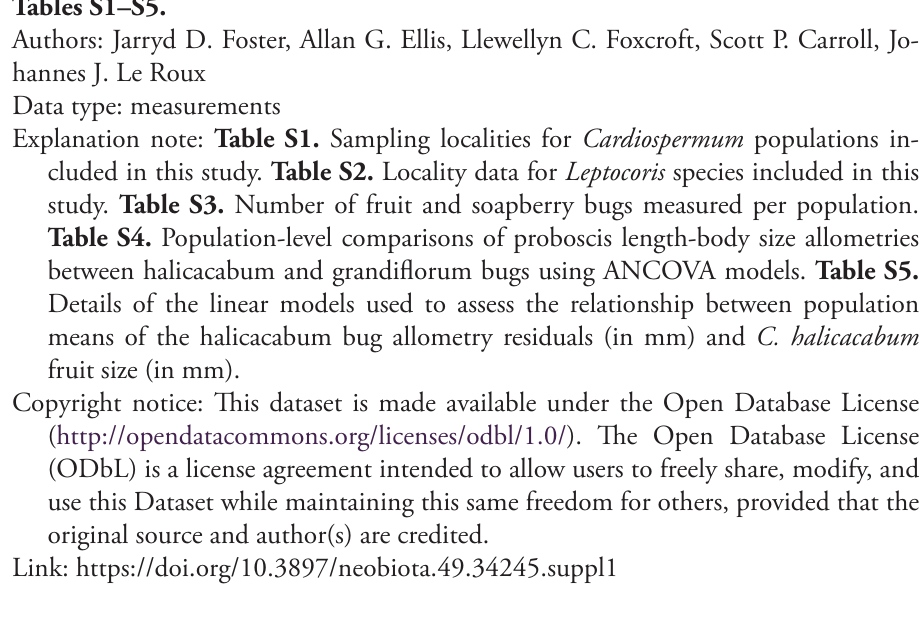
Explanation note: Table S1. Sampling localities for Cardiospermum populations in- cluded in this study. Table S2. Locality data for Leptocoris species included in this study. Table S3. Number of fruit and soapberry bugs measured per population. Table S4. Population-level comparisons of proboscis length-body size allometries between halicacabum and grandiflorum bugs using ANCOVA models. Table S5. Details of the linear models used to assess the relationship between population means of the halicacabum bug allometry residuals (in mm) and C. halicacabum fruit size (in